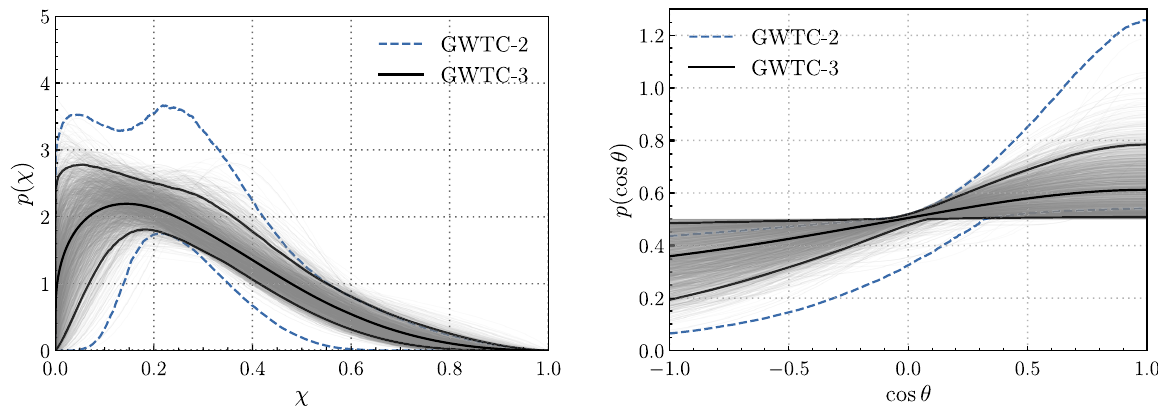
FIG. 15. The distributions of component spin magnitudes χ (left) and spin-orbit misalignment angles θ (right) among binary black hole mergers, inferred using the D EFAULT component spin model described further in Sec. 2 a; e.g., both spin magnitudes are drawn from the same distribution. In each figure, solid black lines denote the median and central 90% credible bounds inferred on p ð χ Þ and p ð cos θ Þ using GWTC-3. The light gray traces show individual draws from our posterior distribution on the D EFAULT model parameters, while the blue traces show our previously published results obtained using GWTC-2. As with GWTC-2, in GWTC-3 we conclude that the spin- 0 . 13 þ 0 . 12 magnitude distribution peaks at χ − 0 . 11 , with a tail extending toward larger values. Meanwhile, we now more strongly favor i ¼ 1 ) but that is otherwise largely uniform across isotropy, obtaining a broad cos θ distribution that may peak at alignment (cos θ i i ¼ all cos θ